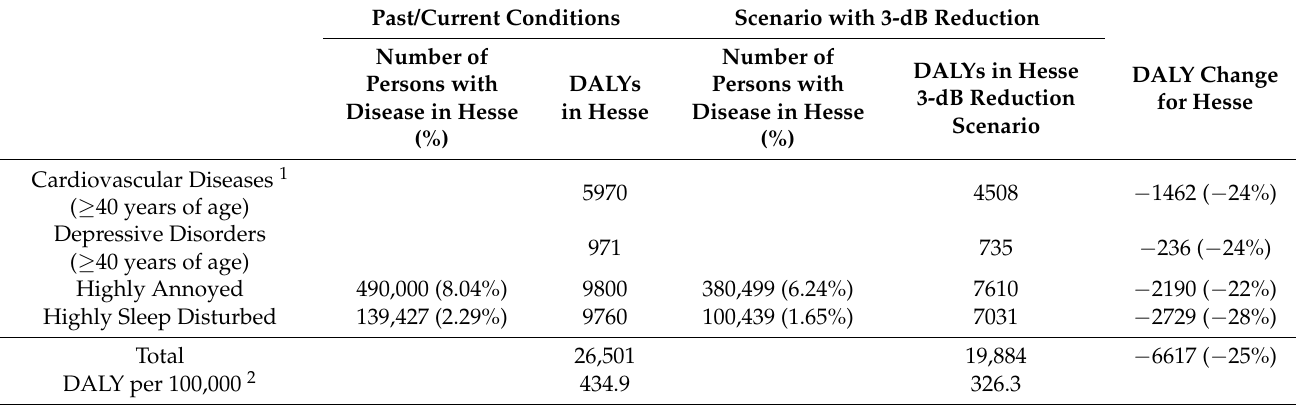
Table 9. The total DALYs attributable to past/current road-traffic noise patterns and assuming a scenario with 3-dB(A) noise reduction in the time before the reference year.